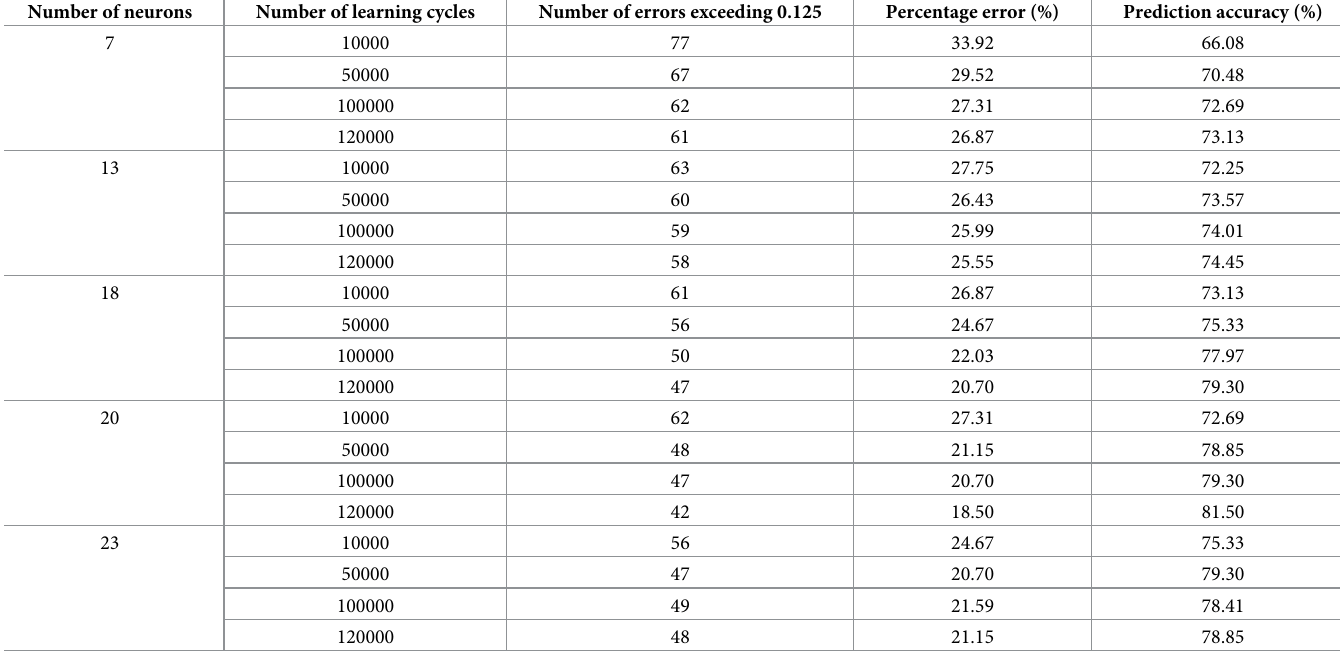
Table 10. BP neural network prediction